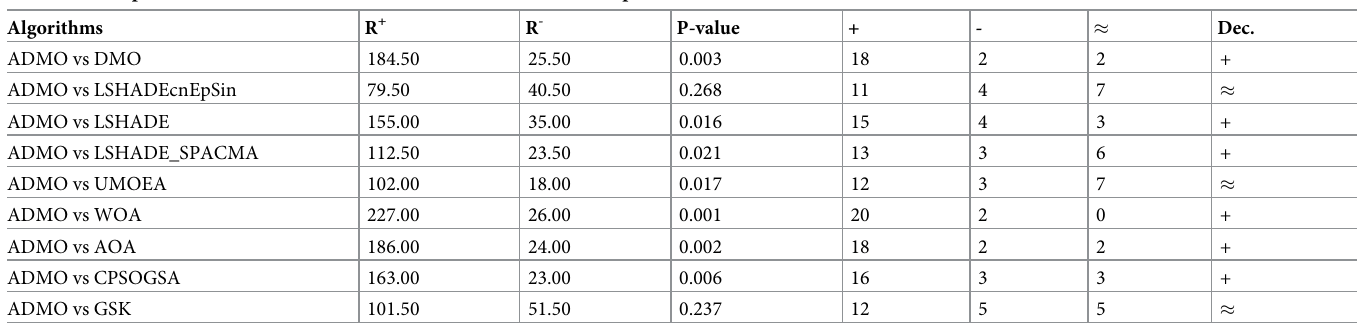
Table 19. Comparative results of Wilcoxon’s test for CEC 2011 real-world